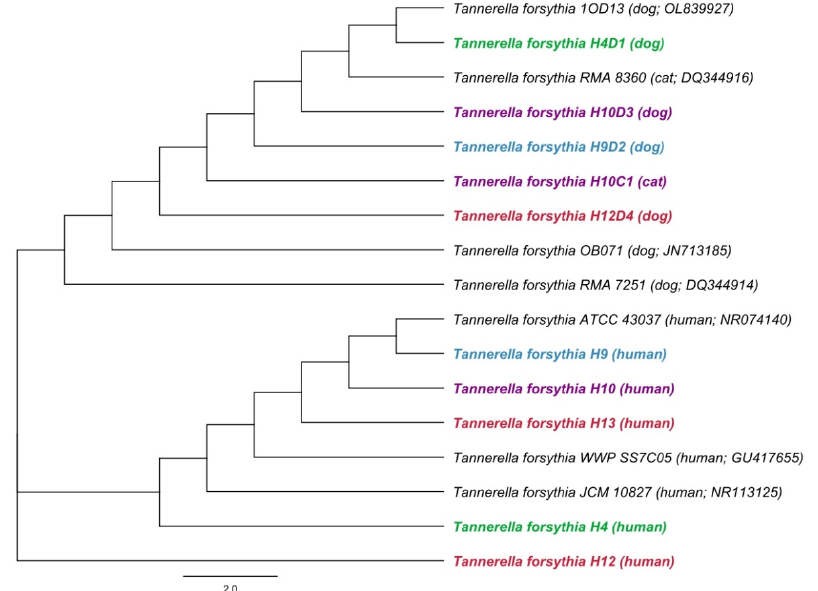
Figure 2. A phylogenetic tree based on comparison of 16S rRNA gene sequences of Tannerella forsythia . A phylogenetic tree was constructed by the neighbor-joining method. Length of 16S rRNA gene sequence used to construct the phylogenetic tree was 480 bp. Hosts and accession numbers for 16S rRNA gene sequences obtained from the GenBank database are given in parentheses. Sequences of owners and their animals are distinguished by different